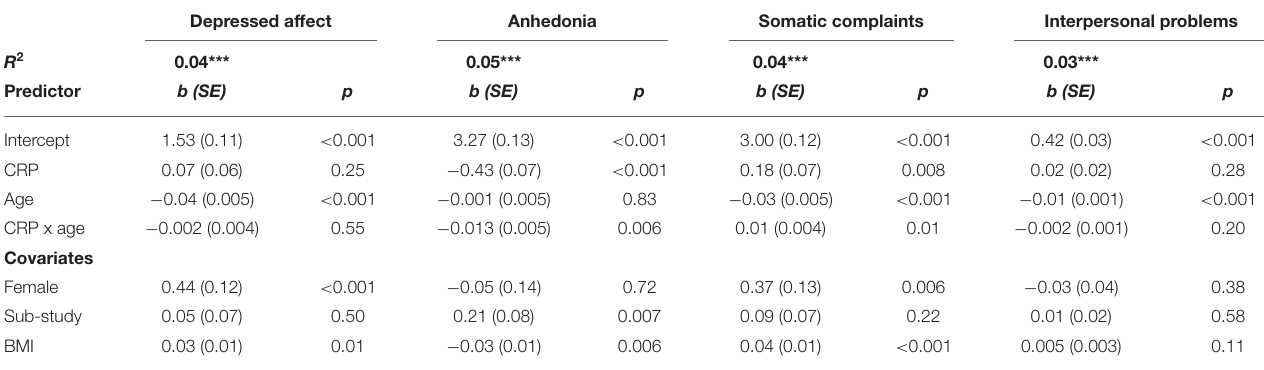
TABLE 3 | Estimated coefficients predicting depressive symptoms and phenotypes from CRP, age, and their